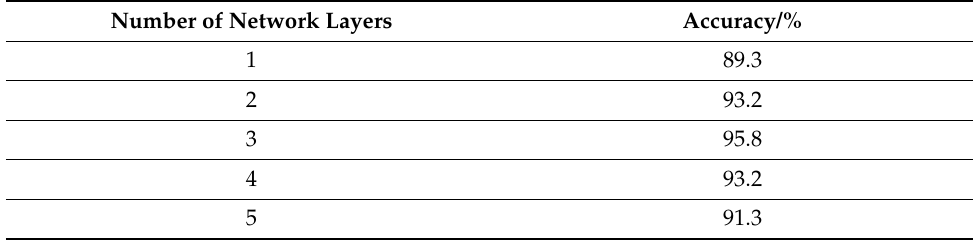
Table 3. Computational accuracy of CNN with different number of layers.